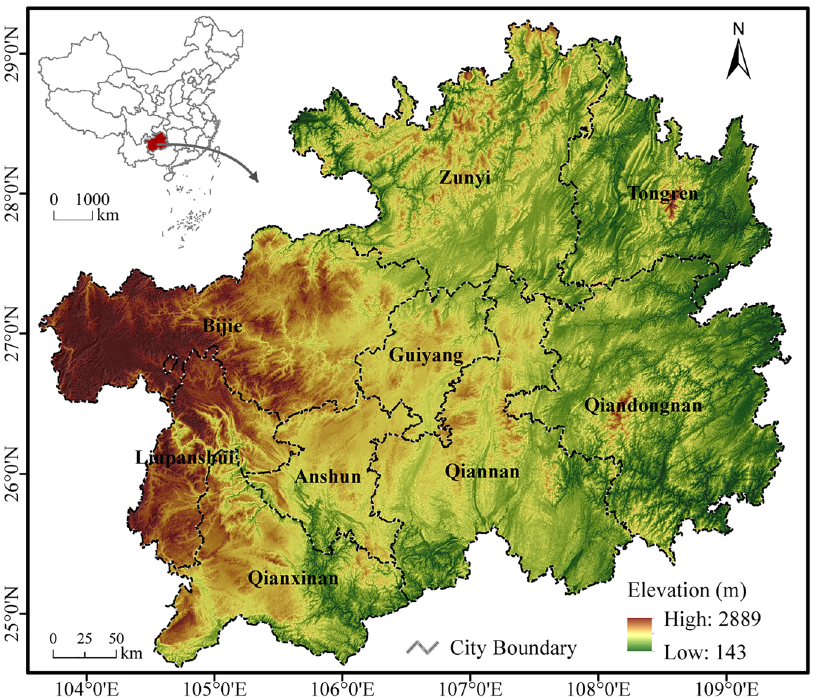
Figure 1. Location of Guizhou Province, China (created by ArcMap, version 10.7, http:// www. esri.